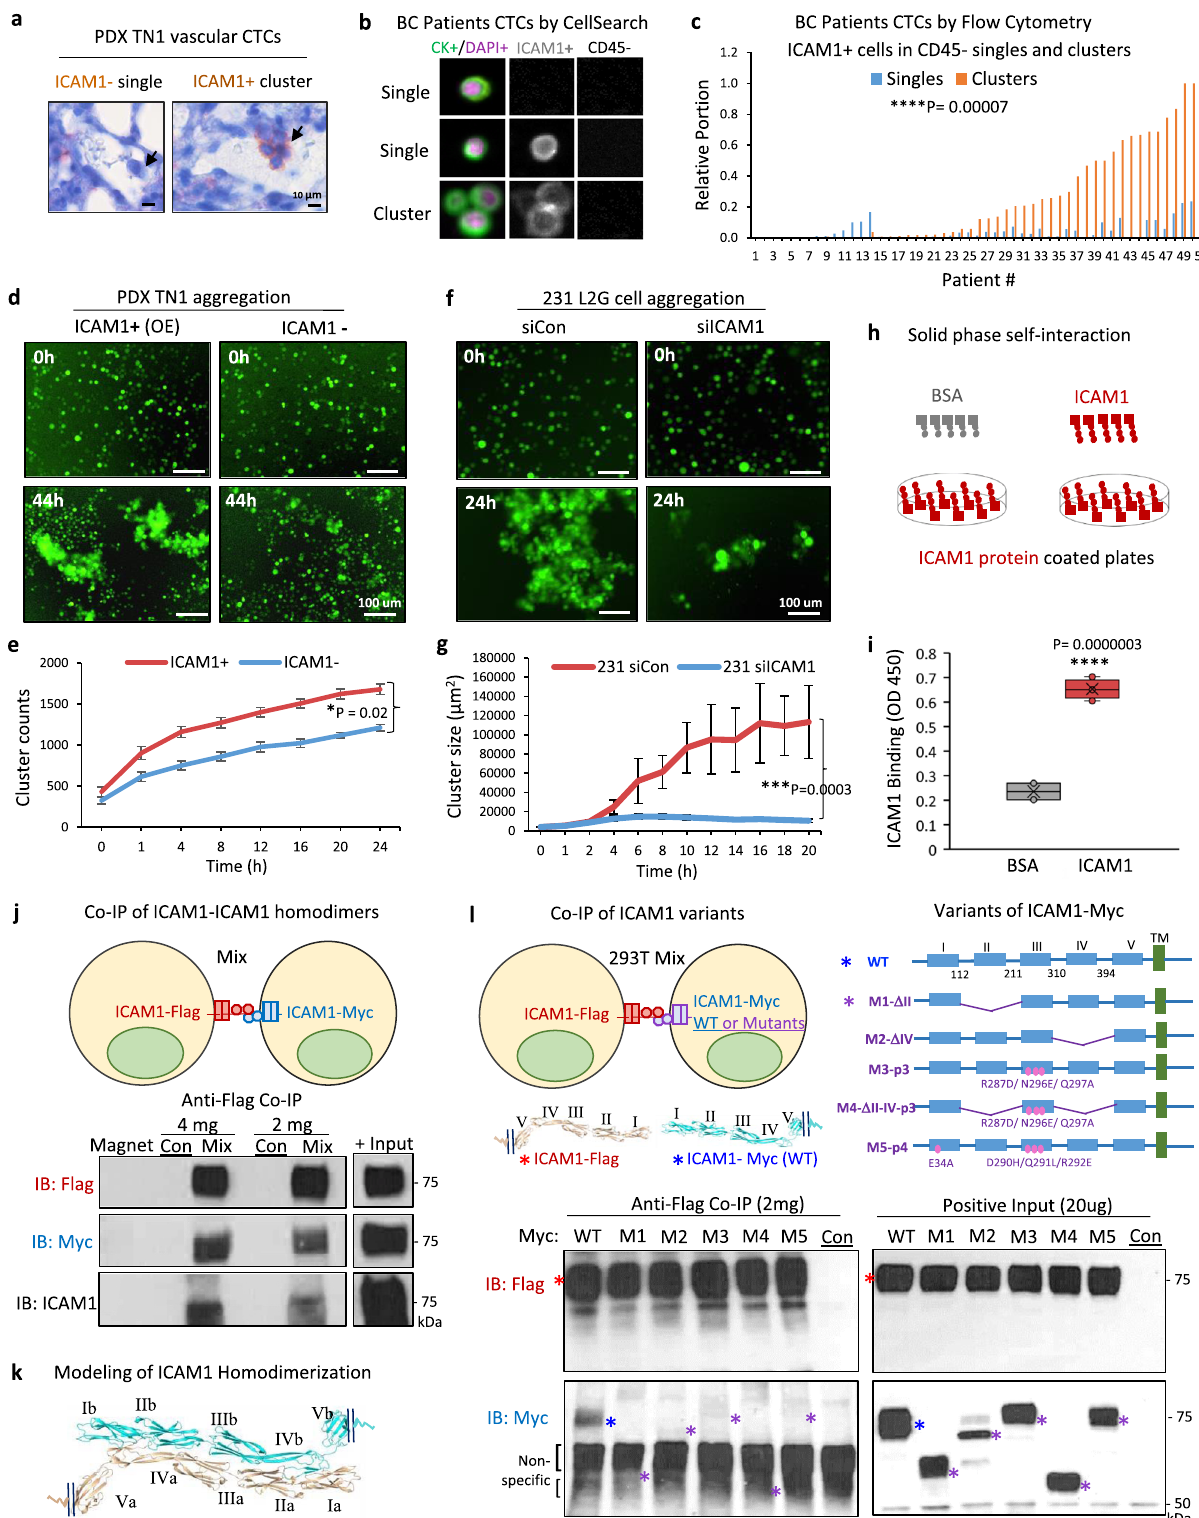
To elucidate the molecular regions required for ICAM homophilic interactions, we analyzed the potential ICAM1 self- binding sites. Based on the predictions of machine